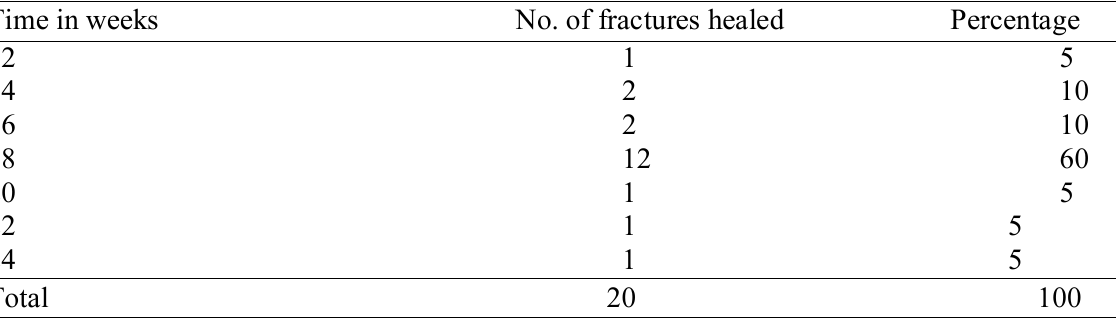
Table 7: Post of complications